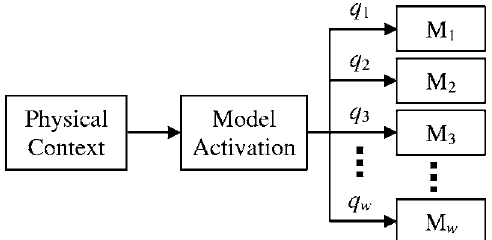
FIG. 1. Using a set of questions designed for a particular phys- ics concept, we can measure the probability for a single student to use different physical models in solving these problems. In the fig- ure, M 1 , ... , M w represent the different physical models (cid:1) there are a total of w physical models including a null model (cid:2) and q 1 , ... , q w represent the probabilities for a student being triggered into activat- ing the